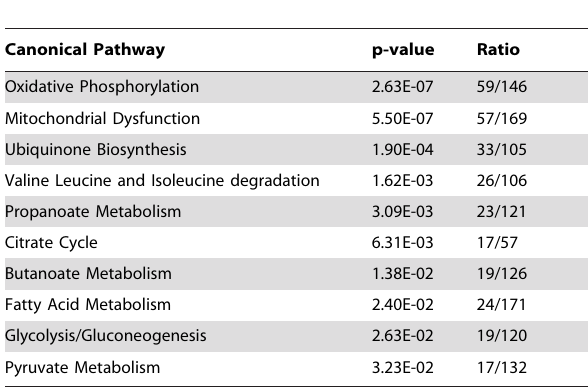
Table 1. Ingenuity Pathway Analysis of 293 proteins labeled by ATP-ABP in mouse skeletal muscle mitochondria lysates from HFD and SD fed mice for 2-, 8-, and